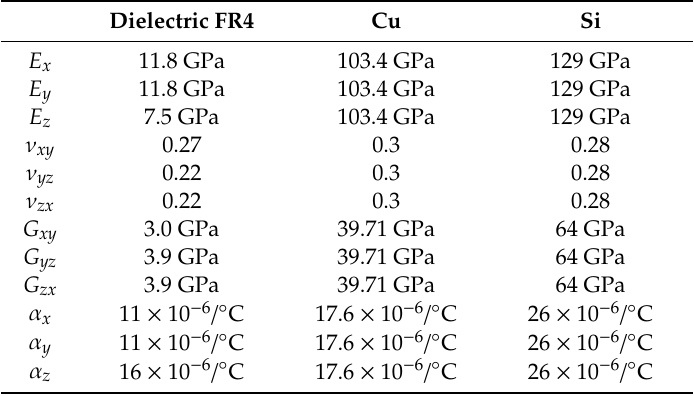
Table 1. Material properties for package substrate